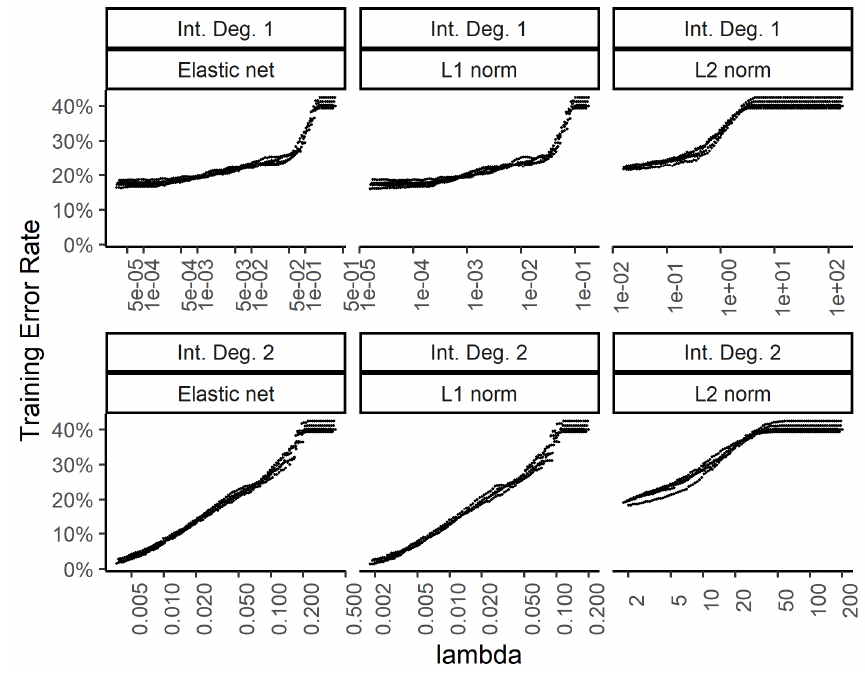
Figure 6. Effect of the weight regularization in the neural network/multinomial regression model on the training set error. The x -axis shows the regularization weight. The top row is for the neural network utilizing the raw input features while the bottom row is for using two-way interactions. The 3 columns show the results for the weight regularization penalty term formulated as an elastic net, L1 norm, and L2 norm.